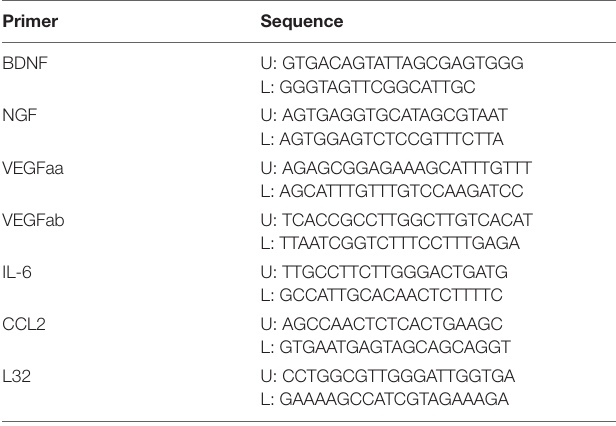
TABLE 2 | Primer sequences for real time